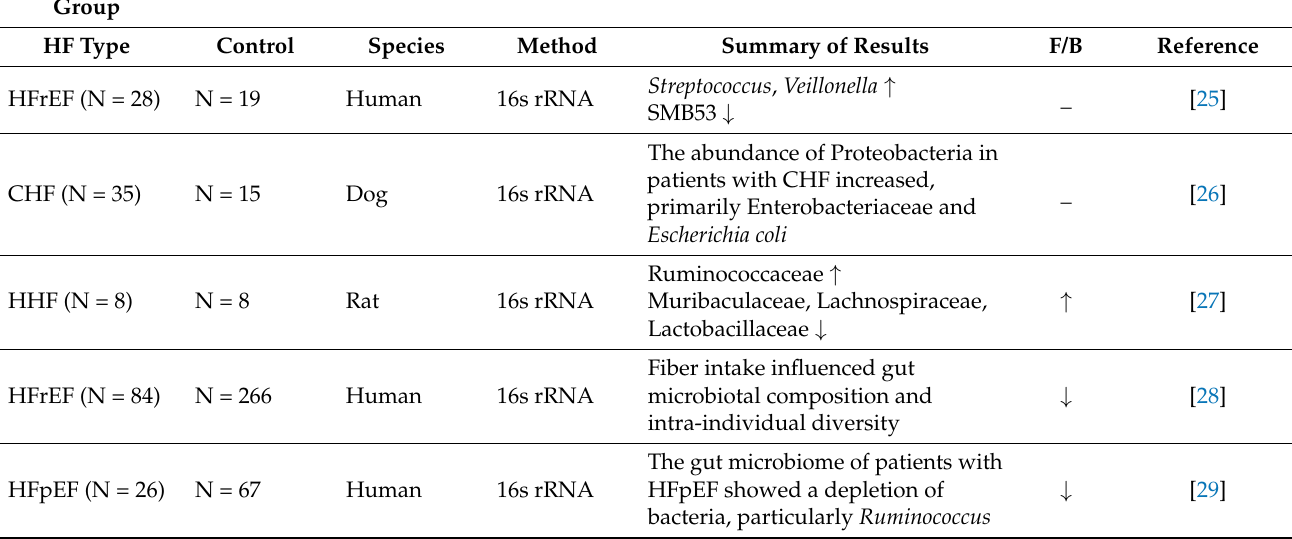
Table 1. Changes in the gut microbiota of HF